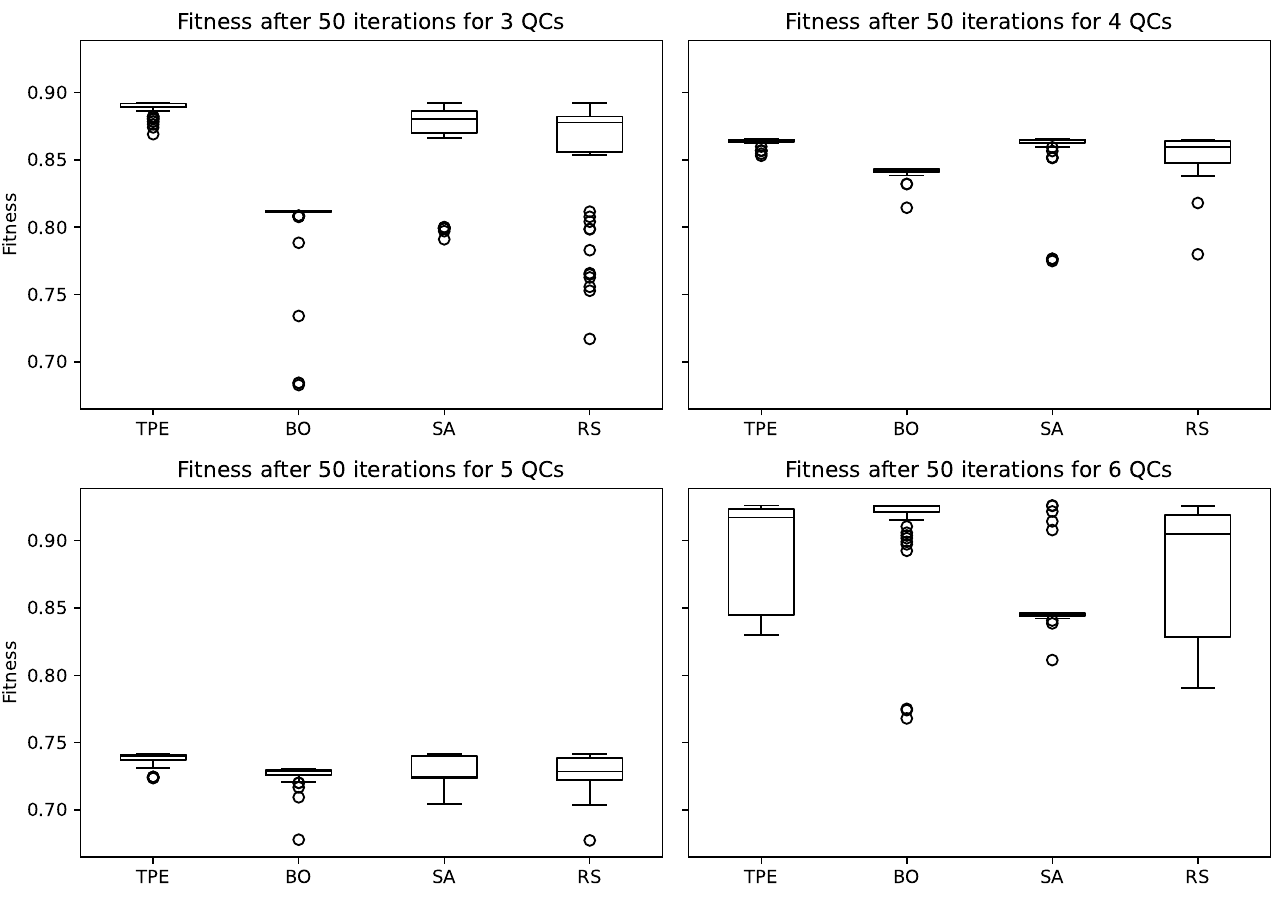
Figure 8. The approximated optima for each scenario and each meta-heuristic. In Figure 9, the frequencies of specific numbers of YBs for 3, 4, 5, and 6 QCs are depicted. A small number of YBs creates a bottleneck in the yard, while having too many YBs leads to a low utilization of each YB as well as longer travel paths of the YTs. The fewer YBs are used, the shorter the traveled paths, the higher the probability that an unloading job and a loading job can be combined. The number of used YBs is often a multiple of the number of QCs. This can be explained by the rather conservative transportation job assignment policy in place, which is designed to avoid traffic jams but rather postpones a job. In Figure 10, the number of YTs per QC for each scenario is presented. The large number of outliers to the right can be explained by the rather small impact of the number of trucks on the weighted utilization and, therefore, on the objective